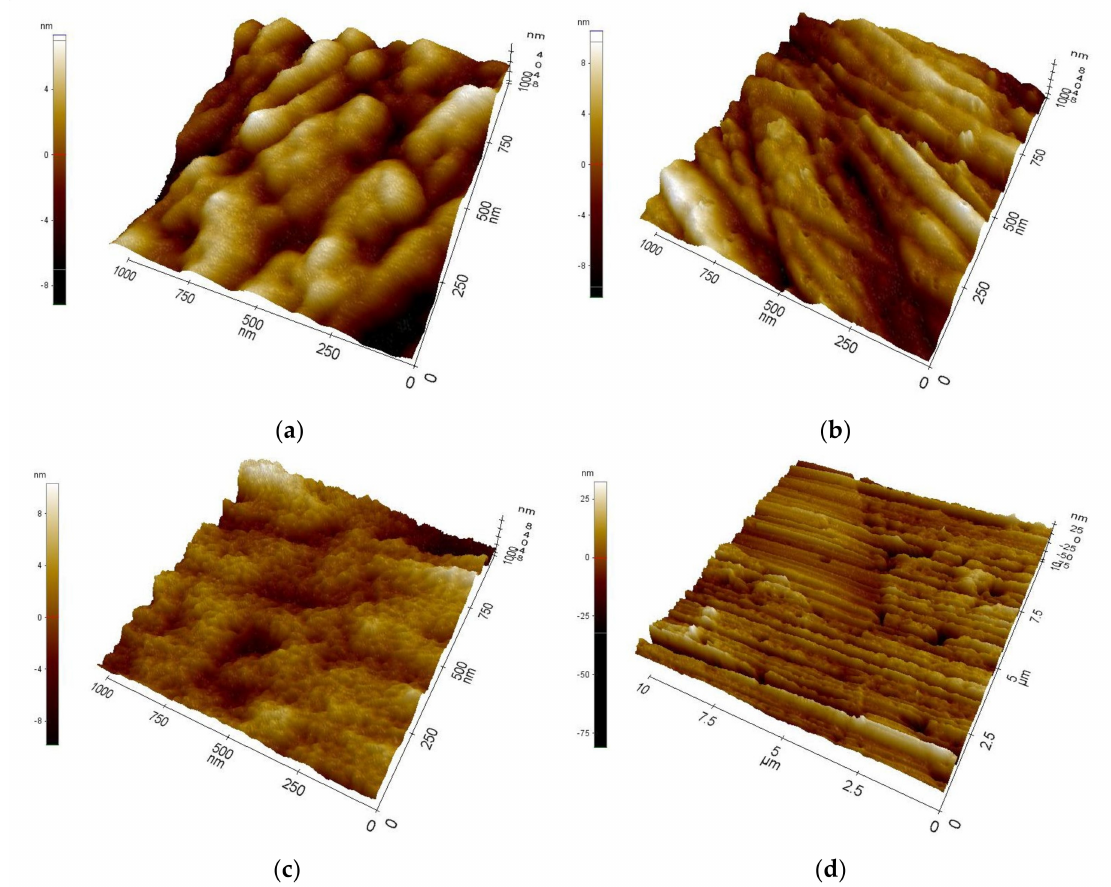
Figure 1. Morphology of investigated coatings on Al-Si-Cu alloy substrate obtained by: ( a ) PVD (1 × 1 µ m AFM image), ( b ) ALD (1 µ m × 1 µ m AFM image), ( c ) hybrid PVD/ALD (1 µ m × 1 µ m